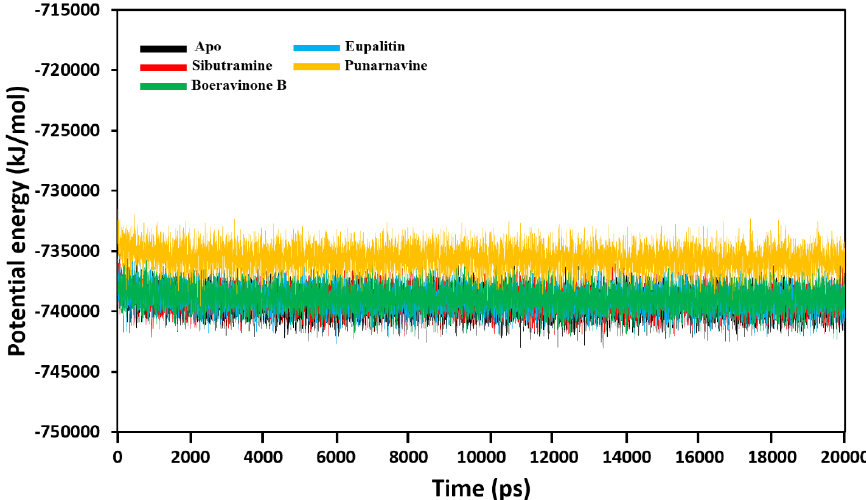
Figure 7. Total potential energies (kJ/mol) of the apo CB1 protein and the CB1 – ligand complexes